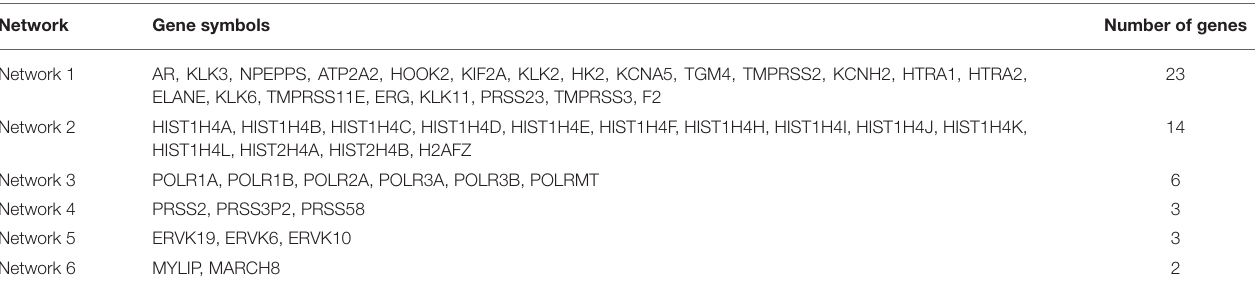
TABLE 5 | Genes belonging to the communities shown in Figure 8B . Network Gene symbols Number of genes Network